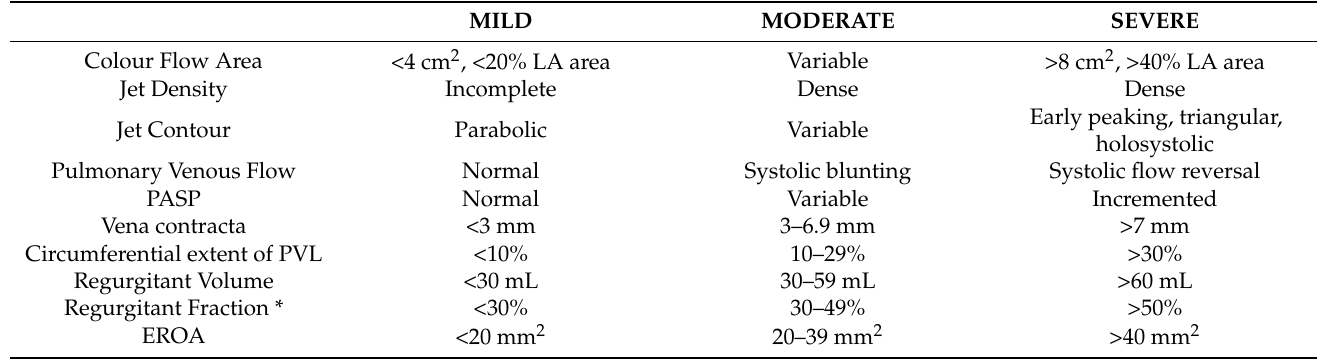
Mitral PVL quantification criteria. * Cardiac MR has the same values for this parameter. Adapted from reference